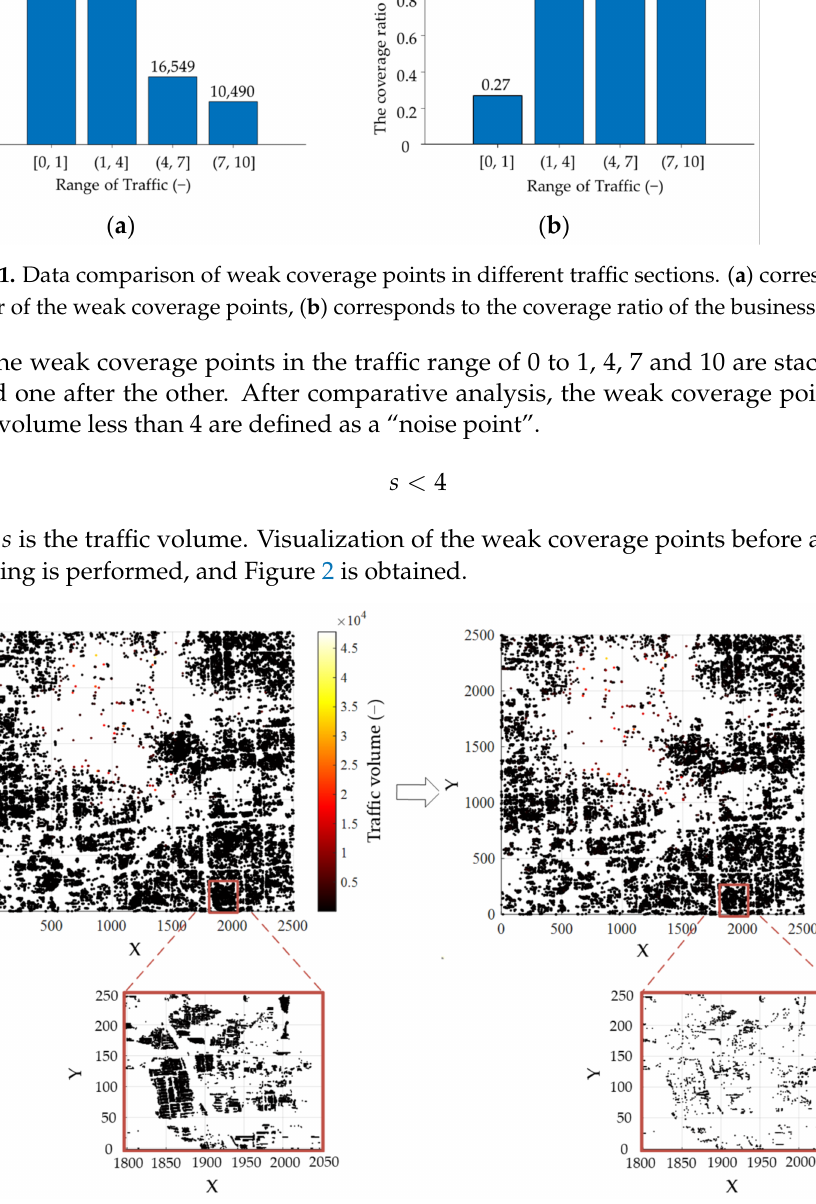
Figure 2. Comparison of signal points before and after noise